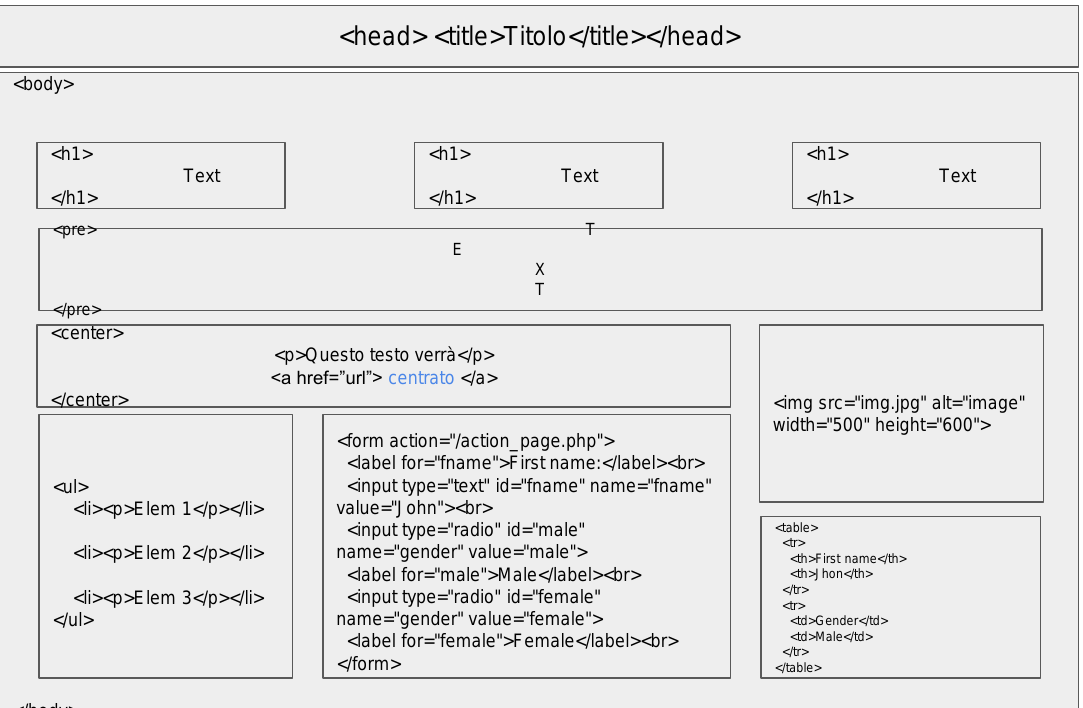
Figure 5. Tags structuring the web page layout.